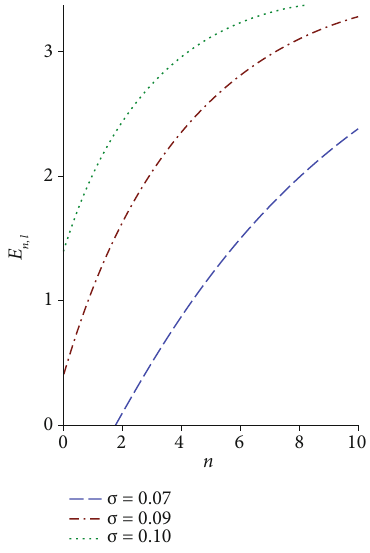
Figure 3: Behavior of energy spectral with respect to n with μ = c = ℏ = 1 , Η = 20 , ϱ = 0 : 1 , Τ = 15 , and D = 5 for σ = 0 : 07 , 0.09, and